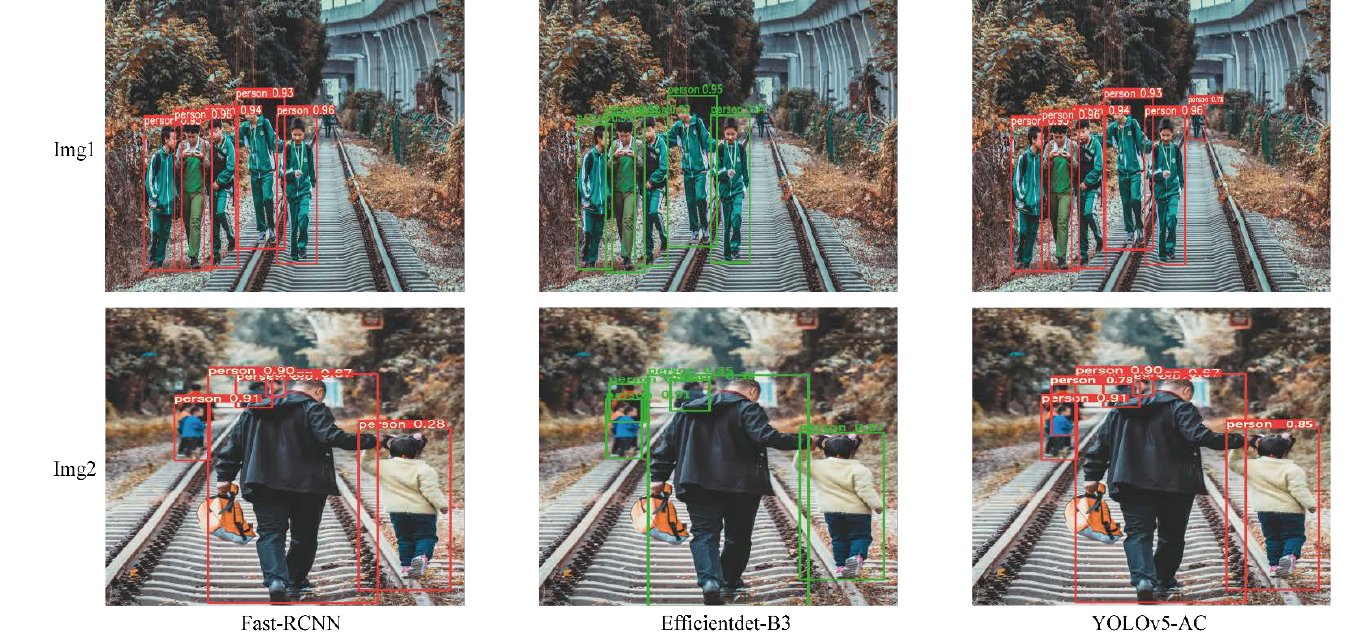
Figure 19. Comparison of training results of YOLOv5-AC and Fast-RCNN and Efficientdet-B3.